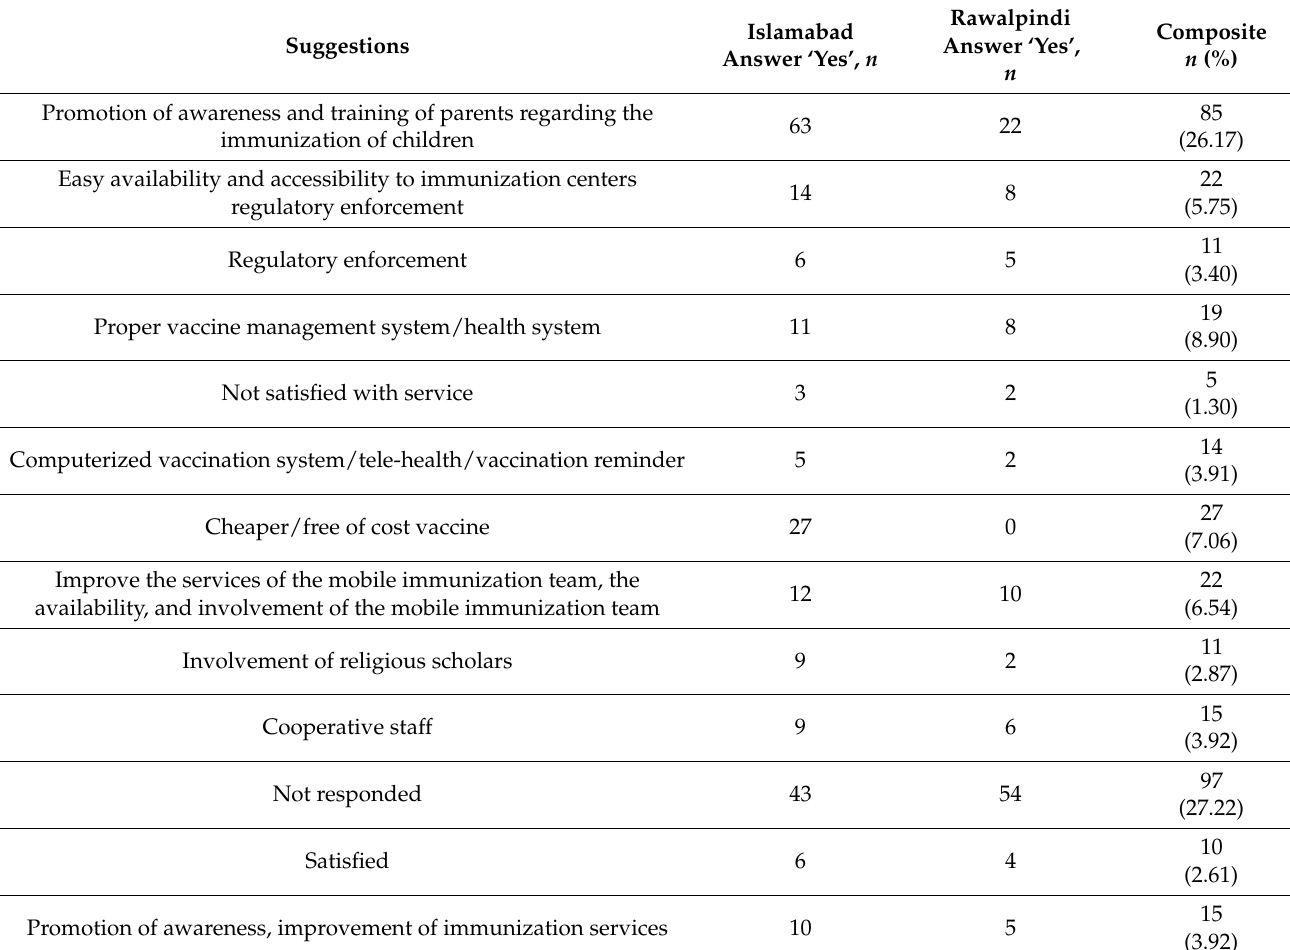
Table 7. Measures to be taken for the improvement of immunization services in